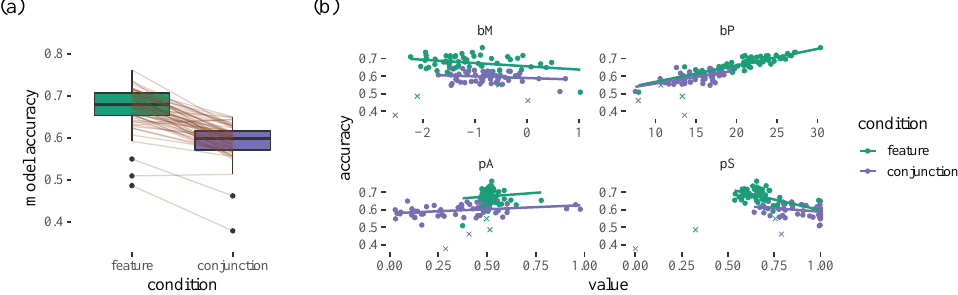
Figure 2. ( a ) Prediction scores for participants. Boxplots show quartile range and the grey lines indicate individual participants. The dots indicate outliers. ( b ) How accuracy of our model varies with the strength of an individual’s bM , bP , pA and pS parameters. We can see two clear outlier participants (marked with an